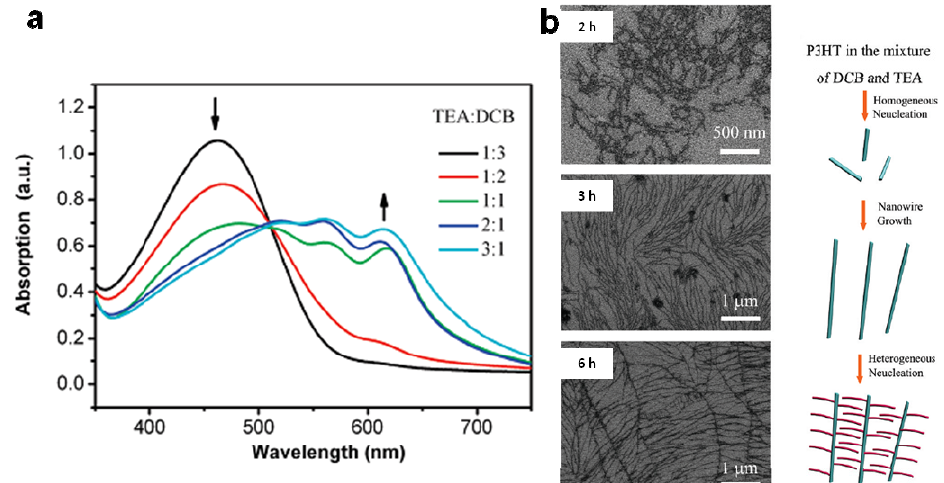
Figure 21. ( a ) The UV-Vis absorption spectra of P3HT solution in dichlorobenzene (DCB)/trimechanolamine (TEA) mixture with different TEA/DCB volume ratio and ( b ) the time-dependent evolution morphology of adding a 30 μ L TEA solution and the growth mechanism of P3HT branched nanostructures, (Adapted with permission from [155]. Copyright 2011 American Chemical